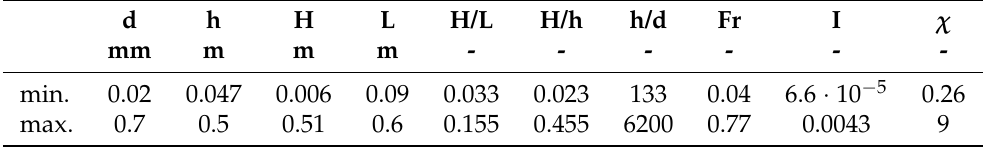
Table 6. The main characteristics of the comparative (data qualified as